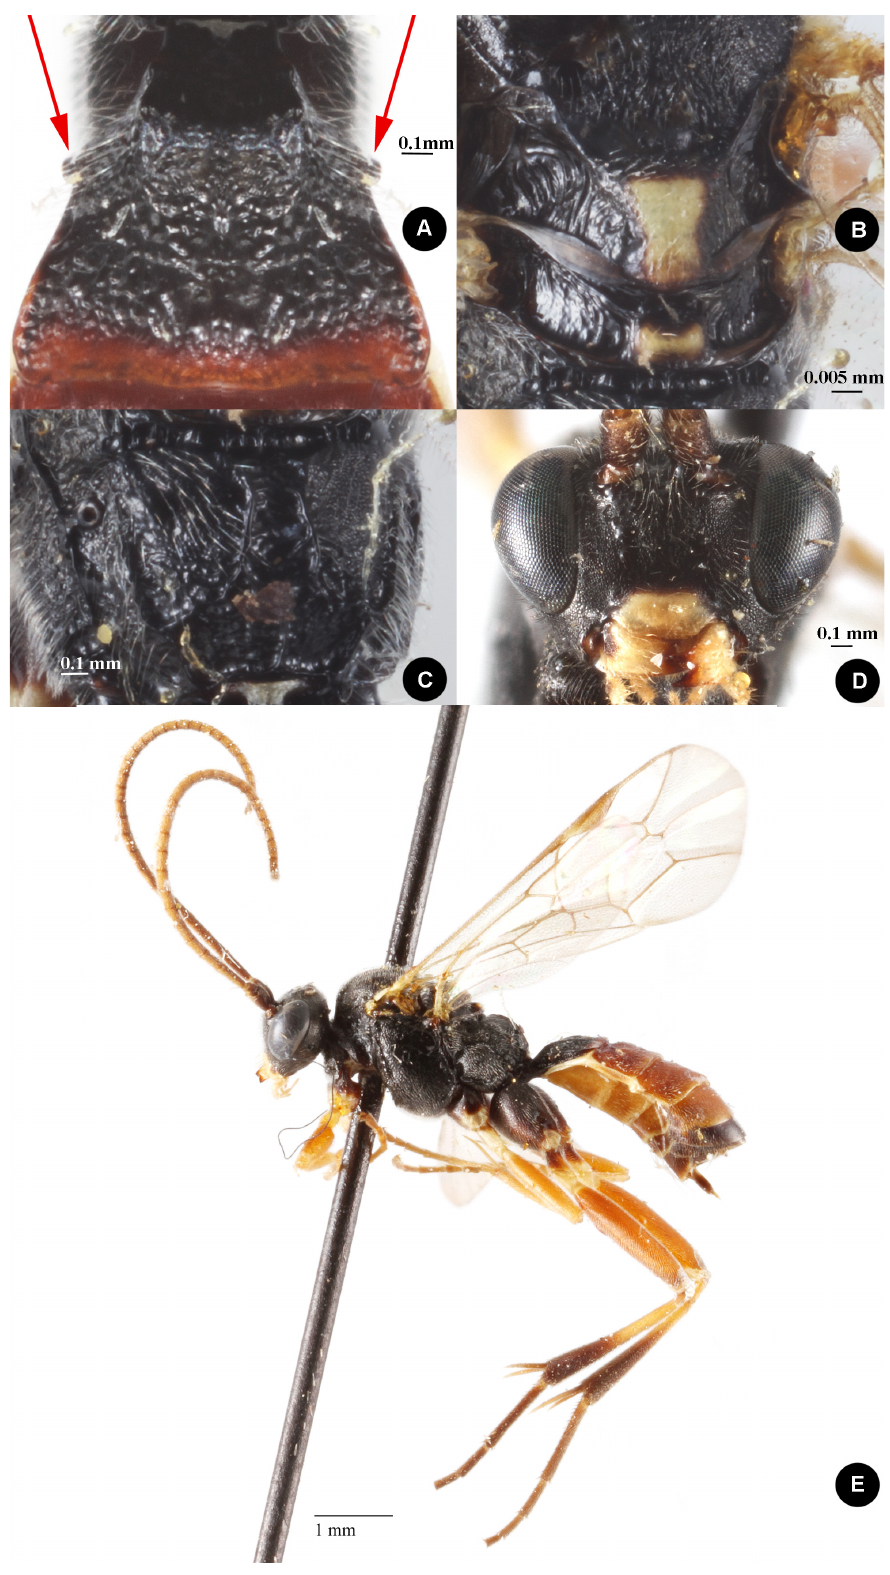
Fig. 7. Rhinotorus leucostomus (Gravenhorst, 1829). A . First metasomal tergite dorsally with projections at spiracles (arrows). B . Mesoscutellum. C . Propodeum. D . Face. E .